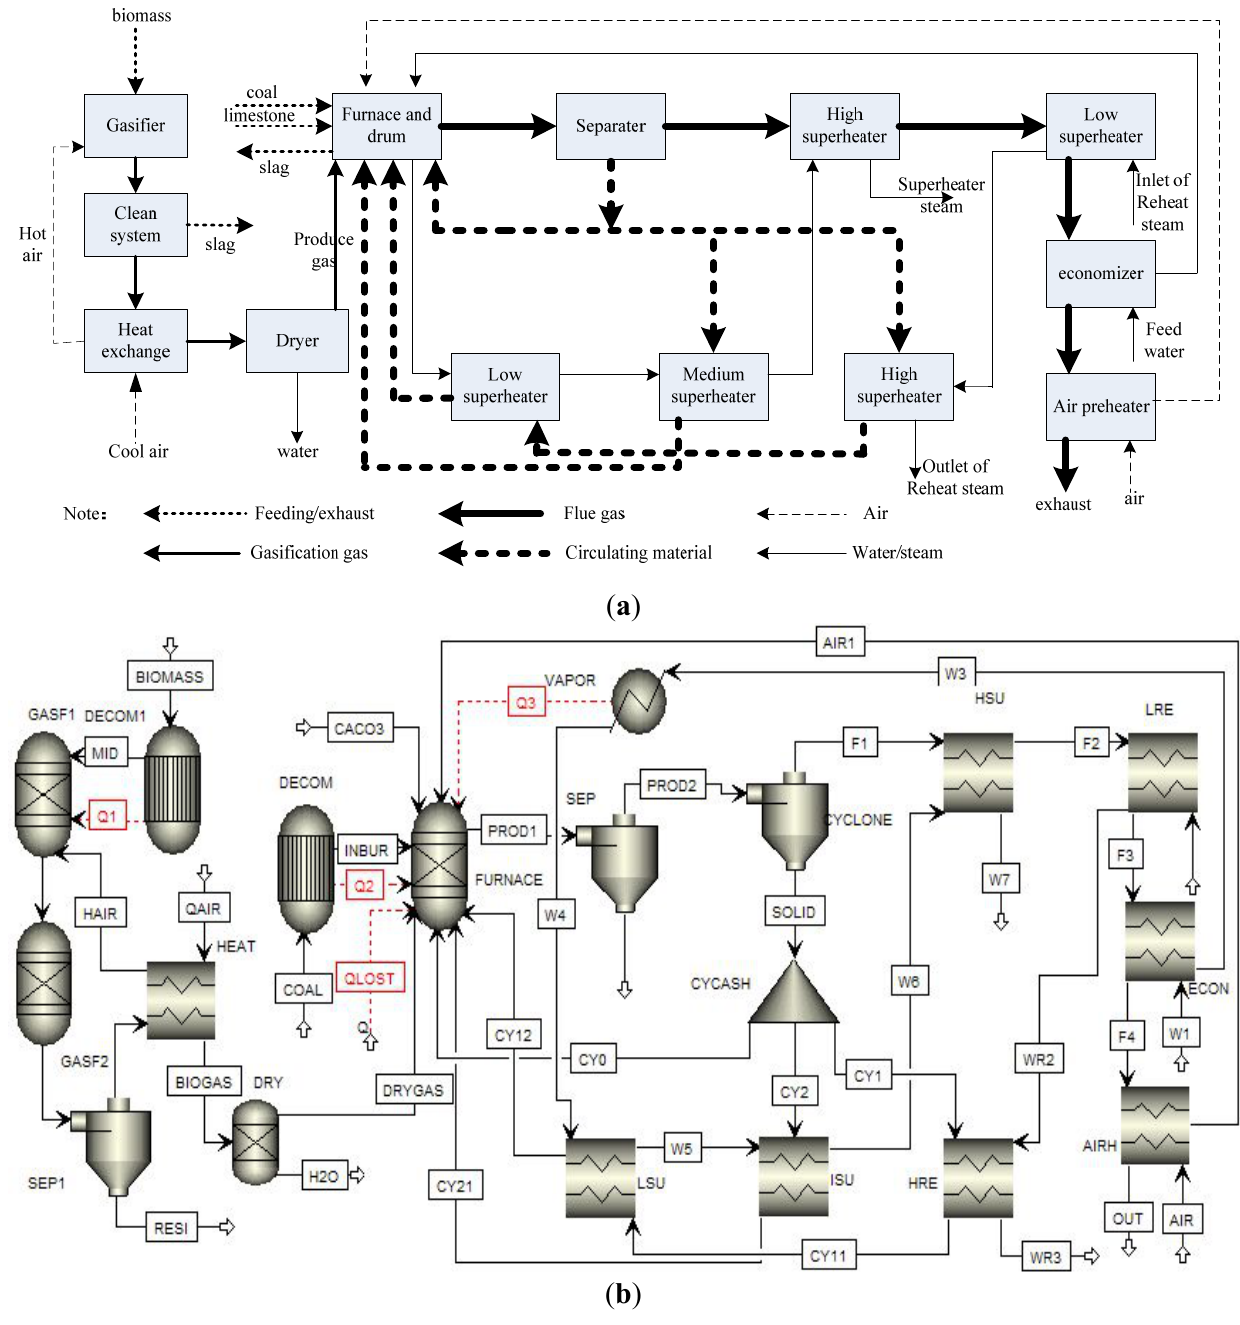
Figure 1. Circulating fluidized bed system integrated with biomass gasification. ( a ) Flow diagram; ( b ) System